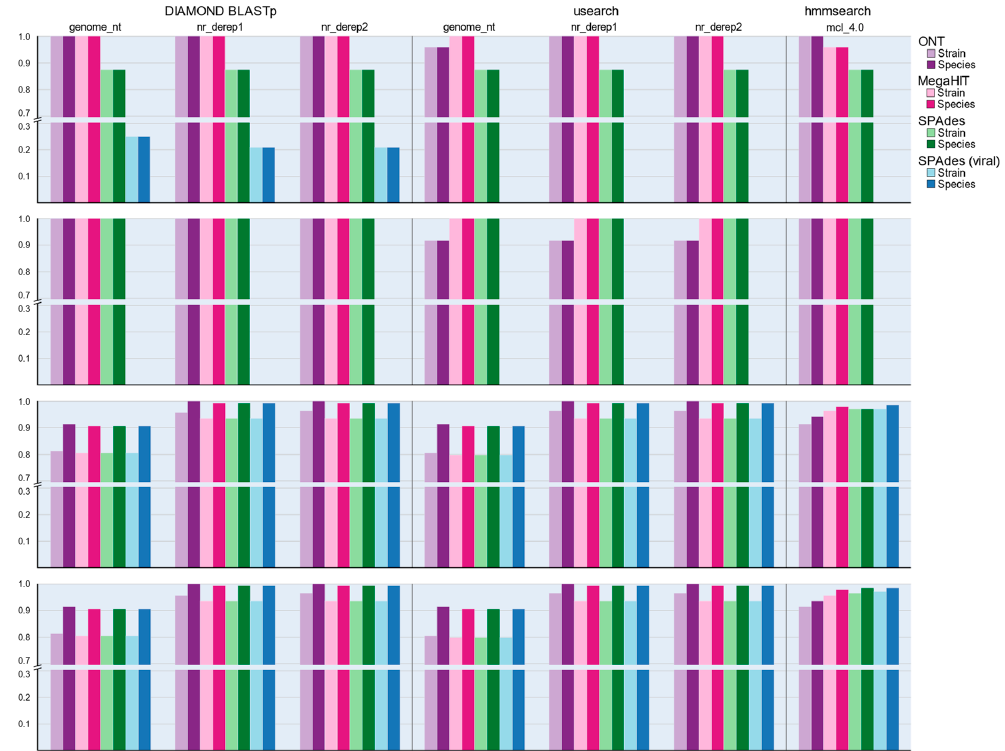
Figure 5. The rate of successful detections at either the strain or species level for each mock library analysis from coding region predictions made using prodigal. Sequence sensitivity for each tool and database combination is reported as the proportion of successful identification events across all samples for the given sequencing platform, as assessed at strain- or species-level resolution. HMM searches against the mcl_4.0 database yielded strong detection sensitivity, es- pecially when considering that the protein models were produced from only the ge- nome_prot sequences and lacks most of the sequences in the nr_derep1 and nr_derep2 databases (Table 2). The mcl_4.0 database outperformed all other protein databases at the strain level (Figure 5) and performed markedly better than the genome_prot database, from which it was generated, at the species level (median sensitivity 98.2% versus ~90.5%). At the resolution of species, the nr_derep1 and nr_derep2 databases both outperformed mcl_4.0 by a small margin, with a sensitivity of 99.3%. However, it is worth noting that the mcl_4.0 database alone cannot predict the species of the proteins detected by the mod- els and a secondary BLASTp was required to assign taxonomy to the proteins identified by the HMM approach. Due to the need for this secondary step, we do not believe that the HMM approach would be ideal for routine diagnostic cases, but it’s superior ability to capture viral protein sequences which are not already present in the database, as shown by the improved sensitivity when compared with the genome_prot database (Figure 5), demonstrates the utility of this approach for detection of novel viral sequences. 3.8. Performance of Analysis Workflows against VIROMOCK Data To further validate our results, we obtained 18 datasets from the VIROMOCK chal- lenge (https://gitlab.com/ilvo/VIROMOCKchallenge, accessed 05/08/2021). These data comprise a mixture of real, synthetic, and artificially spiked sequence libraries to provide an independent test panel for the development of bioinformatic pipelines for virus detec- tion. All datasets were downloaded, quality-filtered, and assembled using MegaHIT, SPAdes, and the appropriate viral SPAdes workflow for the viruses in the dataset. This